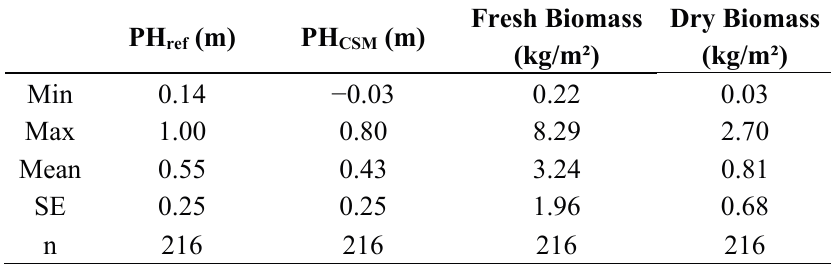
Table 2. Descriptive statistics of CSM plant height (PH ) (linear regression) and above-ground fresh and dry biomass (exponential (PH ref regression) for all plots (n = 216). SE = standard error; n = number of samples.